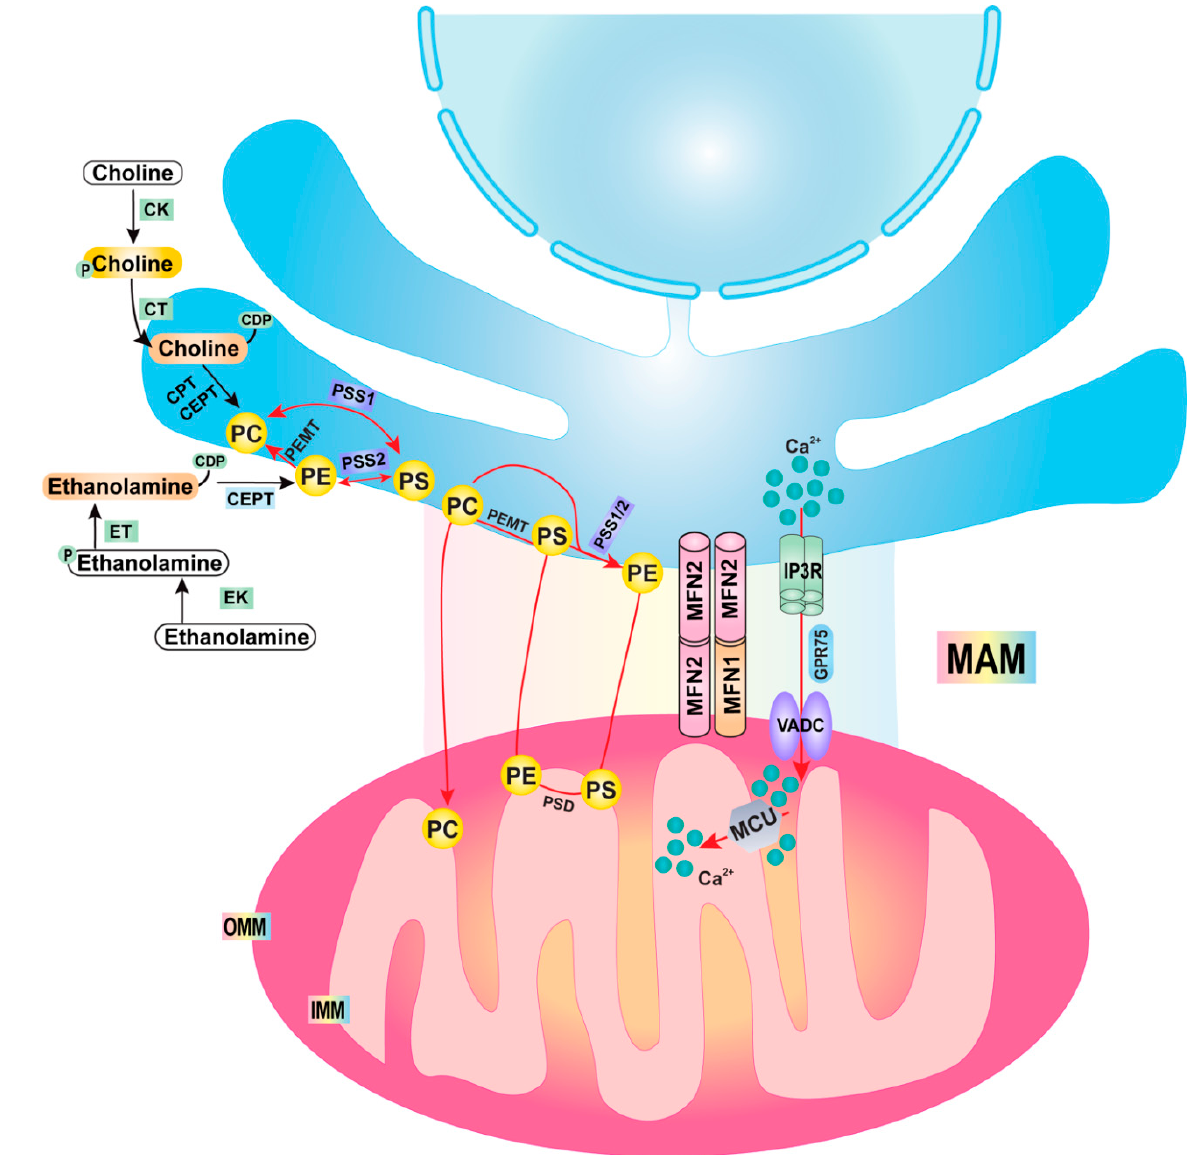
Figure 2. Phospholipid synthesis pathways and membrane contacts. There are two branches of the Kennedy pathway: the CDP-choline and the CDP-ethanolamine pathways. Imported extracellular choline is first phosphorylated by CK (a cytosolic enzyme) to phosphocholine, then converted to CDP-choline by CT (a nuclear and cytosol enzyme), before finally being catalyzed to PC by CPT (an integral ER membrane protein) by transferring a diacylglycerol to CDP-choline. For PE synthesis, ethanolamine is first phosphorylated to phosphoethanolamine by EK (a cytosolic protein), then converted to CDP-ethanolamine by ET (another cytosolic enzyme), before finally being catalyzed to PE by EPT (also an integral ER membrane protein) by transferring a diacylglycerol to CDP-ethanolamine. Alternatively, PE can also be converted to PC by three successive methylation reactions catalyzed by PEMT (an ER/MAM enzyme). In addition, PS is transported to mitochondria and decarboxylated to PE by PSD (an enzyme on the mitochondrial inner membrane). For PS synthesis, PSS1(an enzyme on MAM) catalyzes the exchange of choline for serine in PC, whereas PSS2 (also on MAM) catalyzes the exchange of ethanolamine for serine in PE. Enzymes of the ER membrane are indicated in blue, whereas cytosolic enzymes are in red. Enzymes: CK, choline kinase; CCT, phosphocholine cytidylyltransferase; CPT, cholinephosphotransferase; CTP, phosphocholine cytidylyltransferase (CT); EK, ethanolamine kinase; ECT, phosphoethanolamine cytidylyltransferase; EPT, ethanolaminephosphotransferase; PS decarboxylase (PSD); PS synthase-1 (PSS1); PS synthase-2 (PSS2); MAM: mitochondrial associated membrane; MFN1: mitofusin 1; MFN2: mitofusin 2; IP3R: inositol 1,4,5-trisphosphate receptor; GRP75: glucose-regulated protein 75; MCU: mitochondrial calcium uniporter; VDAC: voltage-dependent anion channel.